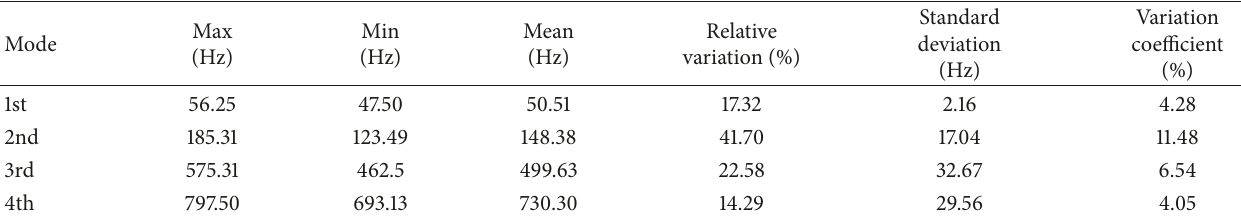
Table 1: Statistics of first four modal frequencies.